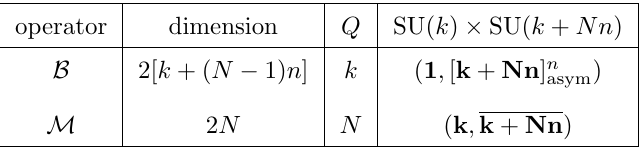
Table 2 . Local operators and their charges.